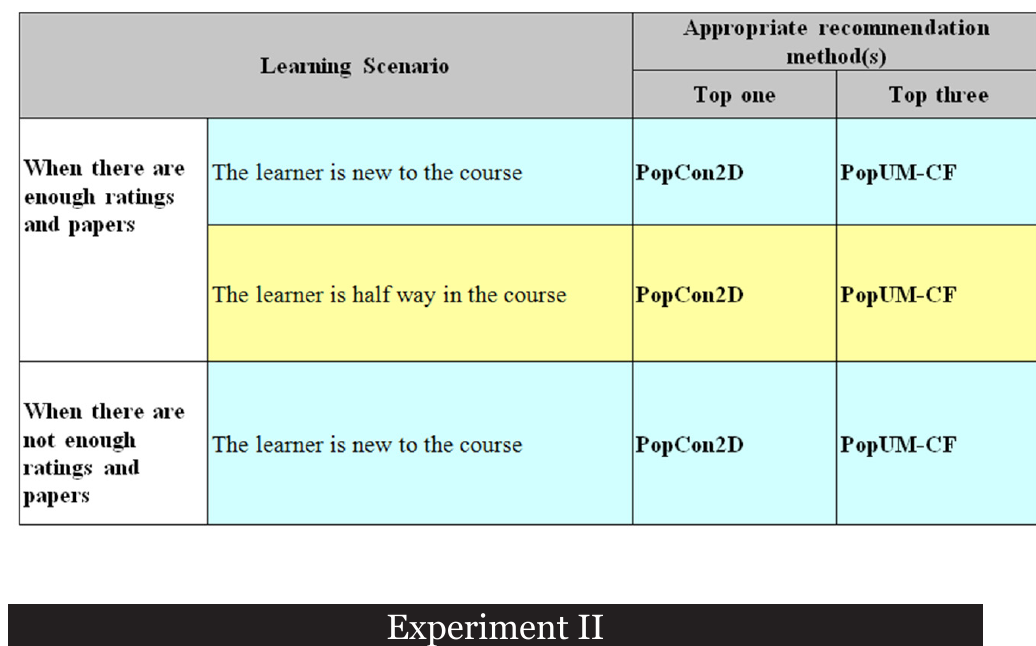
A Summary of Suggested Recommendation